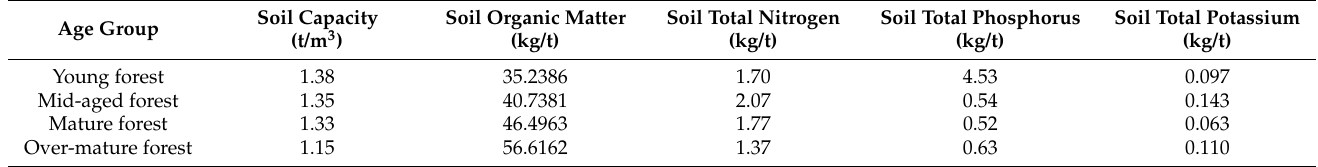
Table 2. Soil nutrients in PM